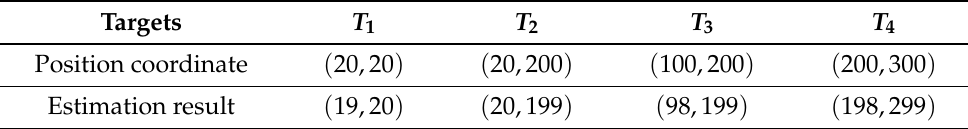
Table 1. The estimated results of multi-target locations.